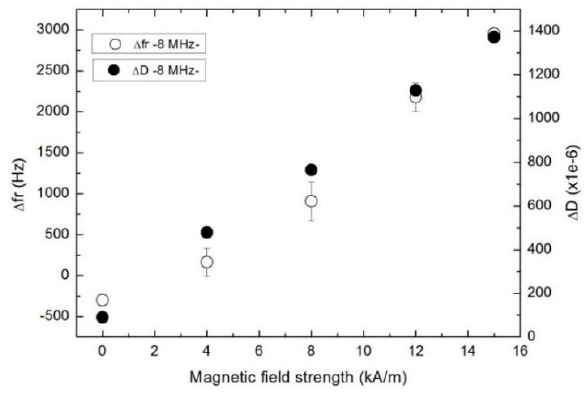
Figure 9. Change in dissipation (solid) and in resonance frequency (open) as a function of the magnetic field intensity applied to the commercial MRF at 8 MHz.